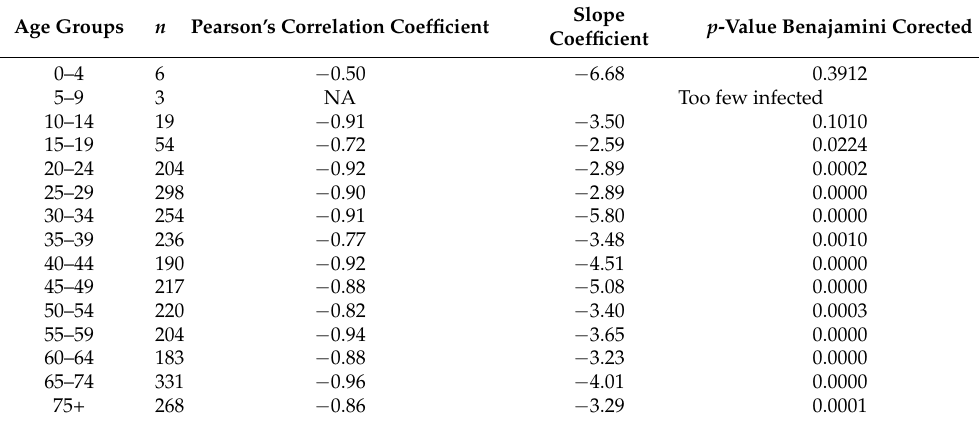
Table 2. Linear trend analysis of the incidence of acute Hepatitis B in different age groups in the Polish population in 2005–2019.